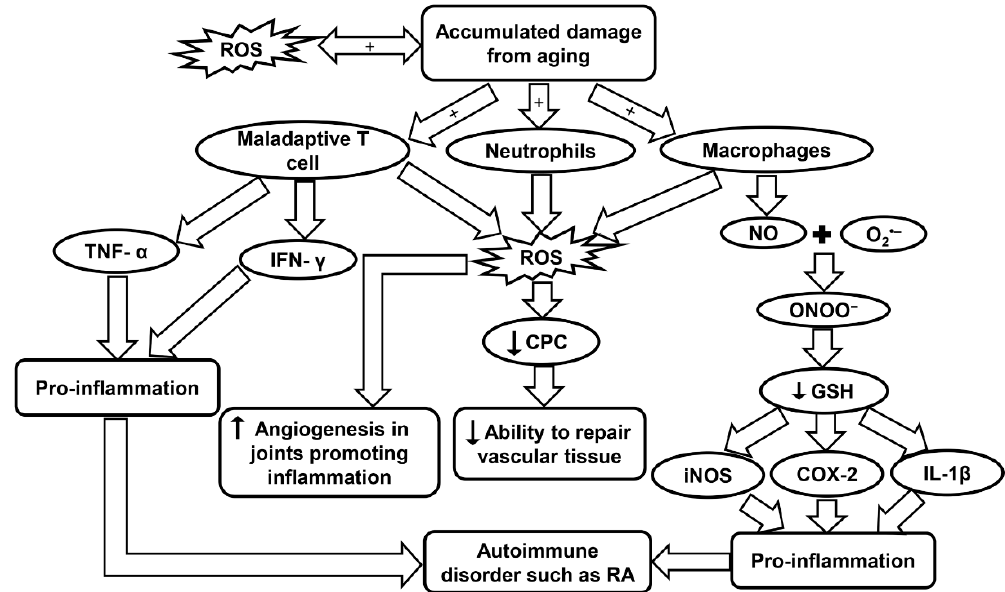
Figure 6. Schematic summarizing the molecular pathways contributing to RA. COX-2, cyclo-oxygenase 2; CPC, circulating progenitor cells; GSH, glutathione; IFN- γ , interferon- γ ; iNOS, inducible nitric oxide synthase; IL-1 β , interleukin-1 β ; RA, rheumatoid arthritis; ROS, reactive oxygen species; TNF- α , tumor necrosis factor- α .